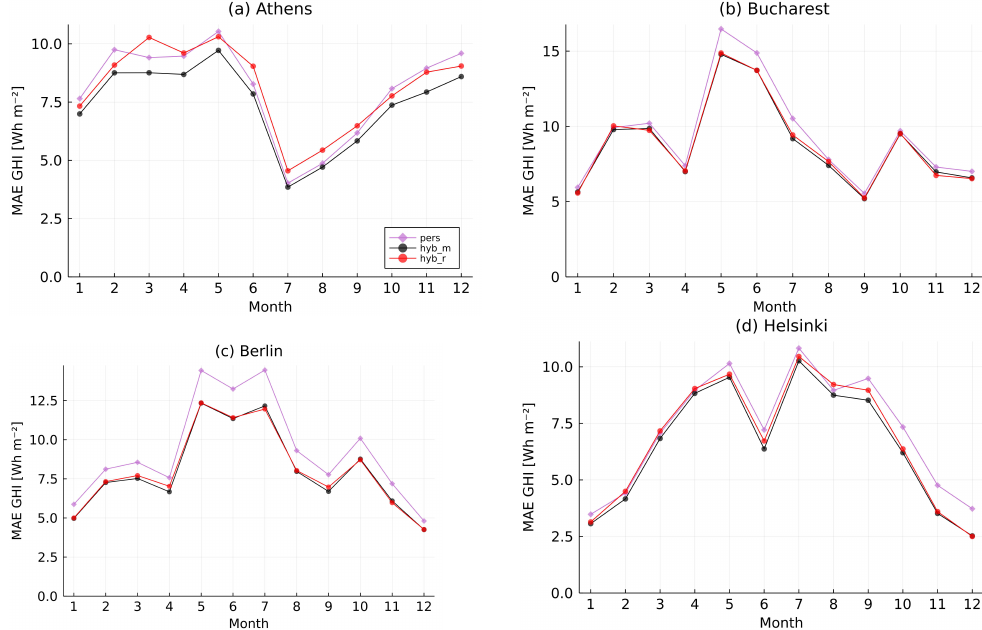
Figure 15. MAE of 1 h ahead GHI for the persistence and hybrid approaches in 2020 for ( a ) Athens, ( b ) Bucharest, ( c ) Berlin, and ( d )